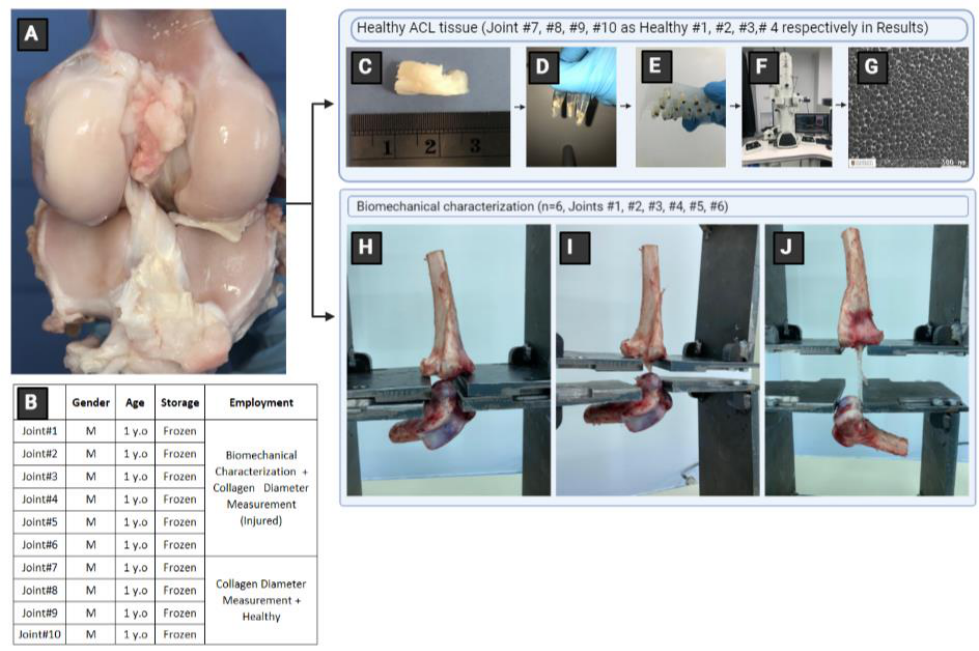
Figure 1. Procedure for ACL extraction and characterization. ( A ) Sheep knee joint, ( B ) characteristics of the harvested ACL tissues, ( C – G ) sample preparation and characterization using TEM, and ( H – J ) mechanical characterization (M, male).